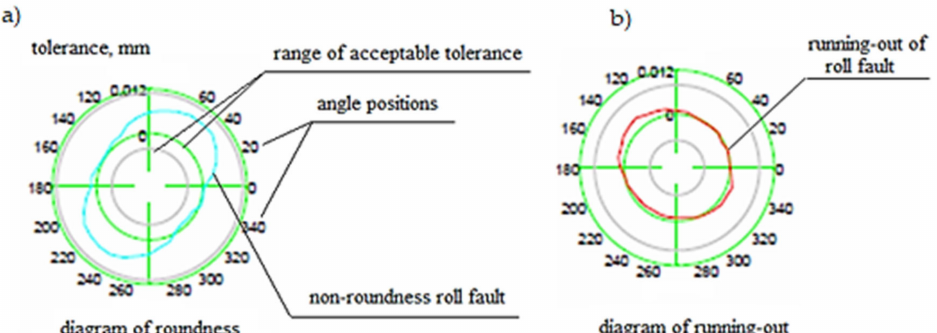
Figure 5. Diagram of defects of rolls made of high chromium cast iron Hi-Cr: ( a ) irregularities, ( b ) run-out. Source: own, based on